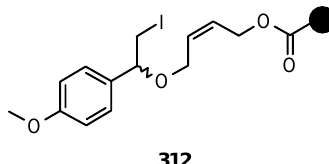
Figure 108. Structure of alkyl radical precursor 312